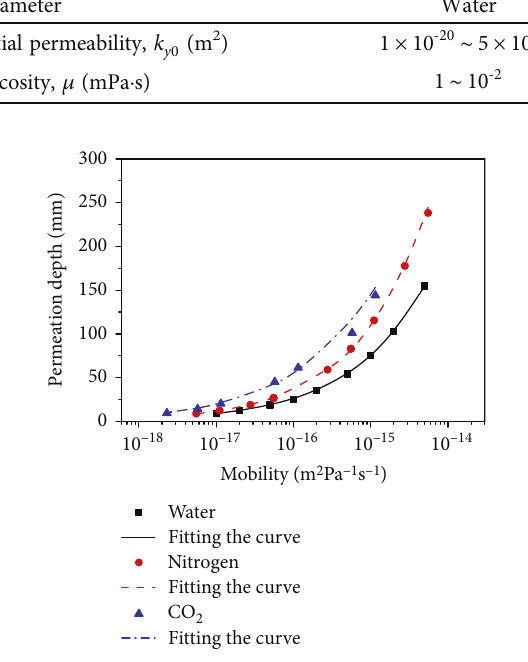
Figure 6: Changes of permeation depth with mobility during water and gas